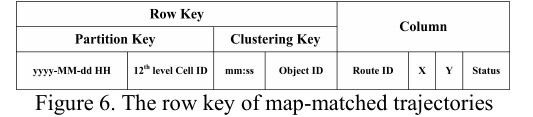
Figure 6. The row key of map-matched trajectories